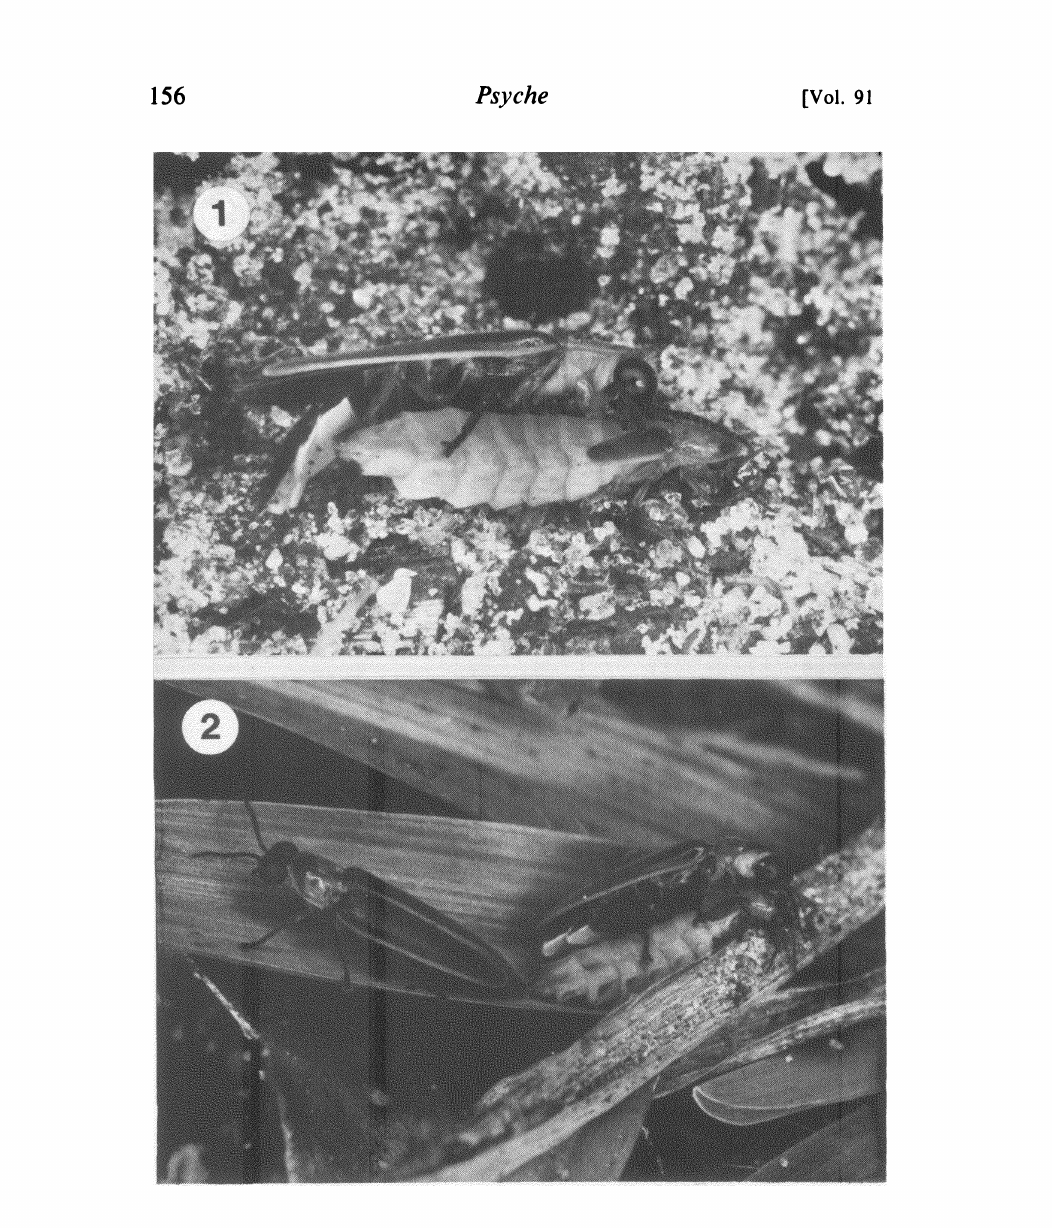
Fig. 1. Photinus collustrans male (above) mounting female. Note burrow opening in background. The female is about 11 mm long. Fig. 2. Photinus collustrans trio. Male on left is copulating. Rival has mounted